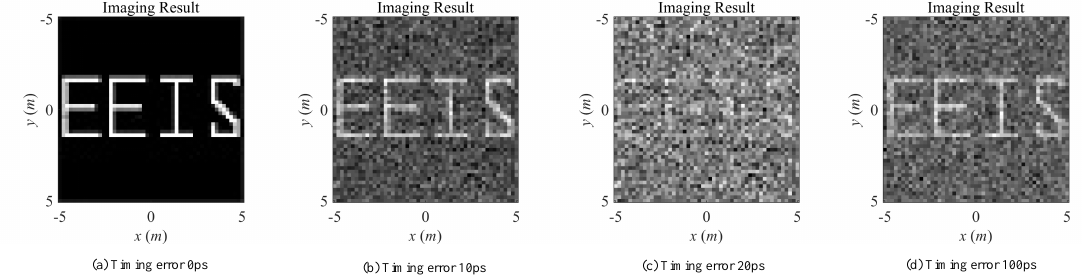
Figure 6. Imaging results with different levels of timing mismatch errors.